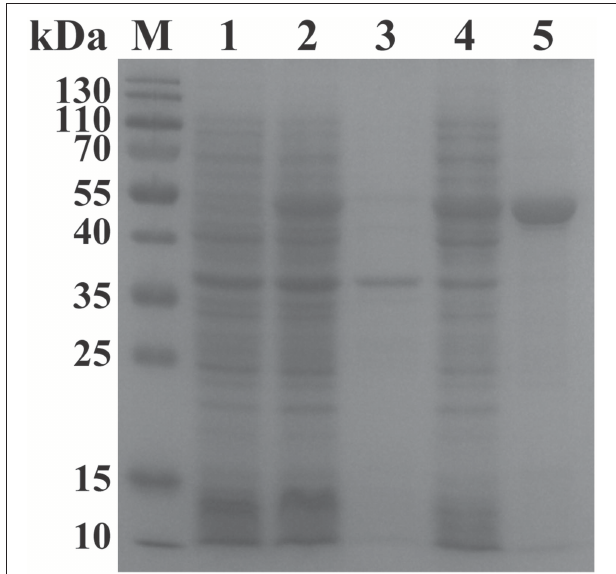
FIGURE 2 | SDS-PAGE analysis of the recombinant BgGPI47-WH. Lane M: Protein marker; lane 1: Induced protein; lane 2: Non-induced protein; lane 3: Precipitated his-BgGPI47-WH in cell lysates; lane 4: Soluble his-BgGPI47-WH in cell lysates; lane 5: Purified recombinant BgGPI47-WH protein.